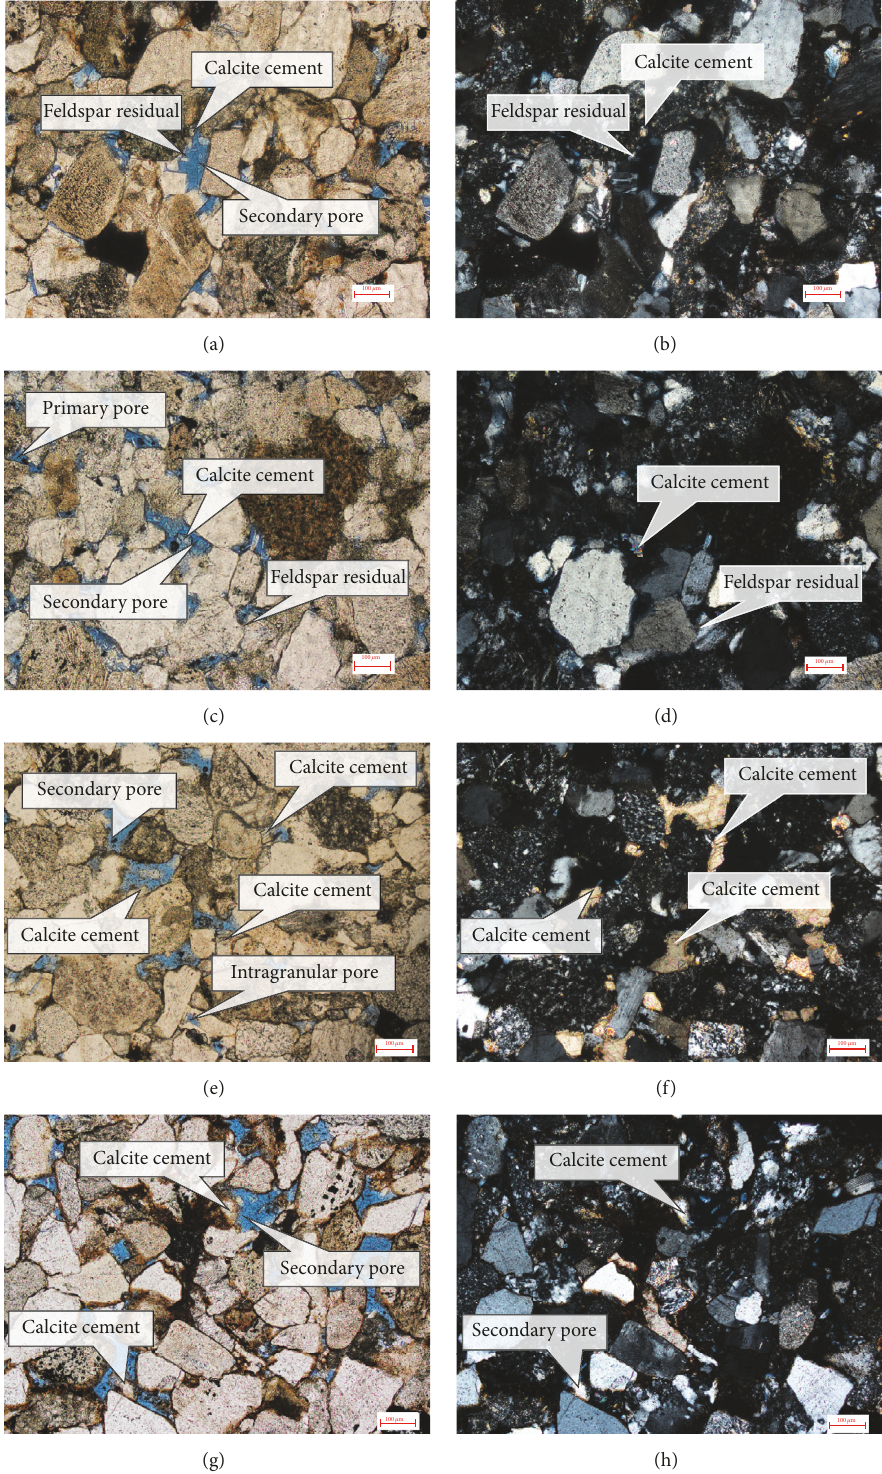
Figure 9: Photomicrographs of petrographic features of the Xishanyao Formation sandstones. Full view of pores and intergranular secondary pores develops from a blue-epoxy-impregnated thin sections of conventional core samples. The remnant of calcite and feldspar can be found after dissolution. (a), (b) Y2 well at 5961.5 m with magnification of 40; (c), (d) Y6 well at 5978 m with magnification of 40; (e), (f) Y1 well at 5876.3 m with magnification of 40; (g), (h) Y7 well at 6102.95 m with magnification of